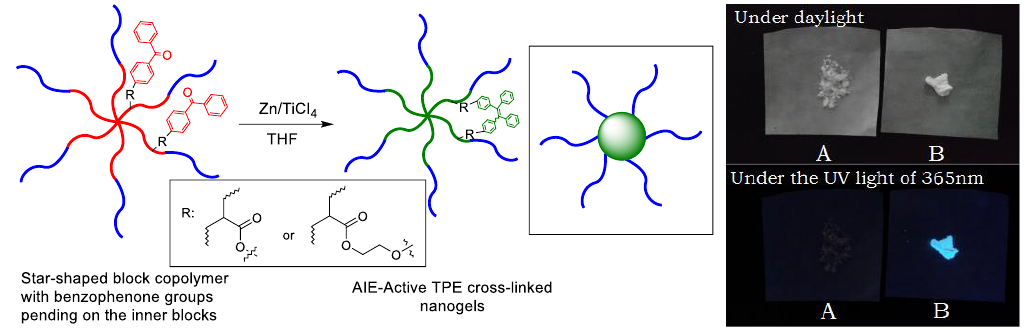
and responding nanogel (B).